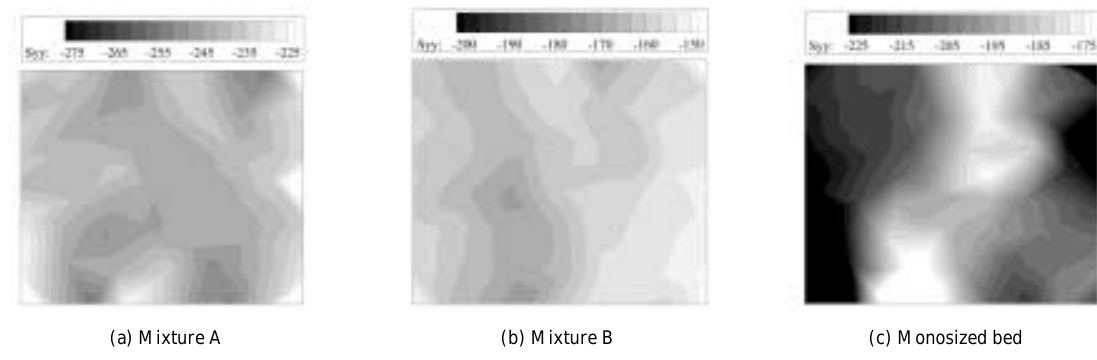
Fig. 5 The local stress contours of (a) mixture A; (b) mixture B; (c) monosized